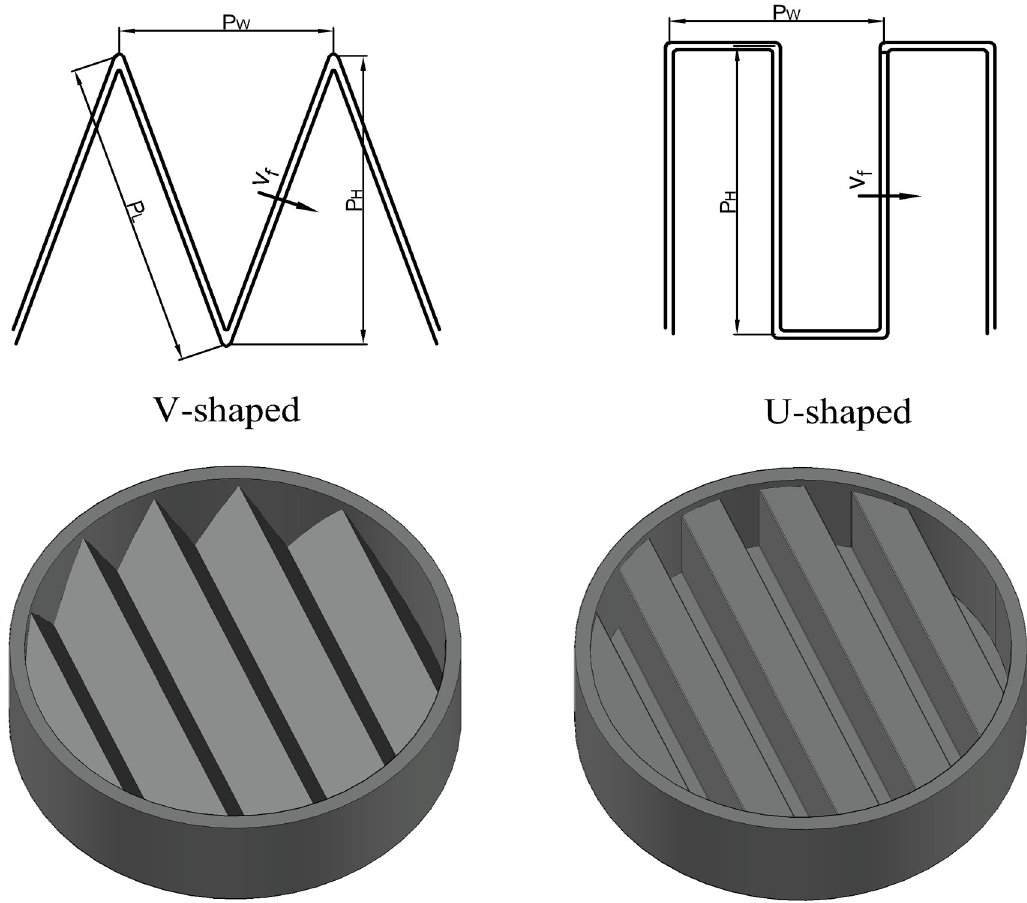
Fig 3. Geometric structures of the pleats.